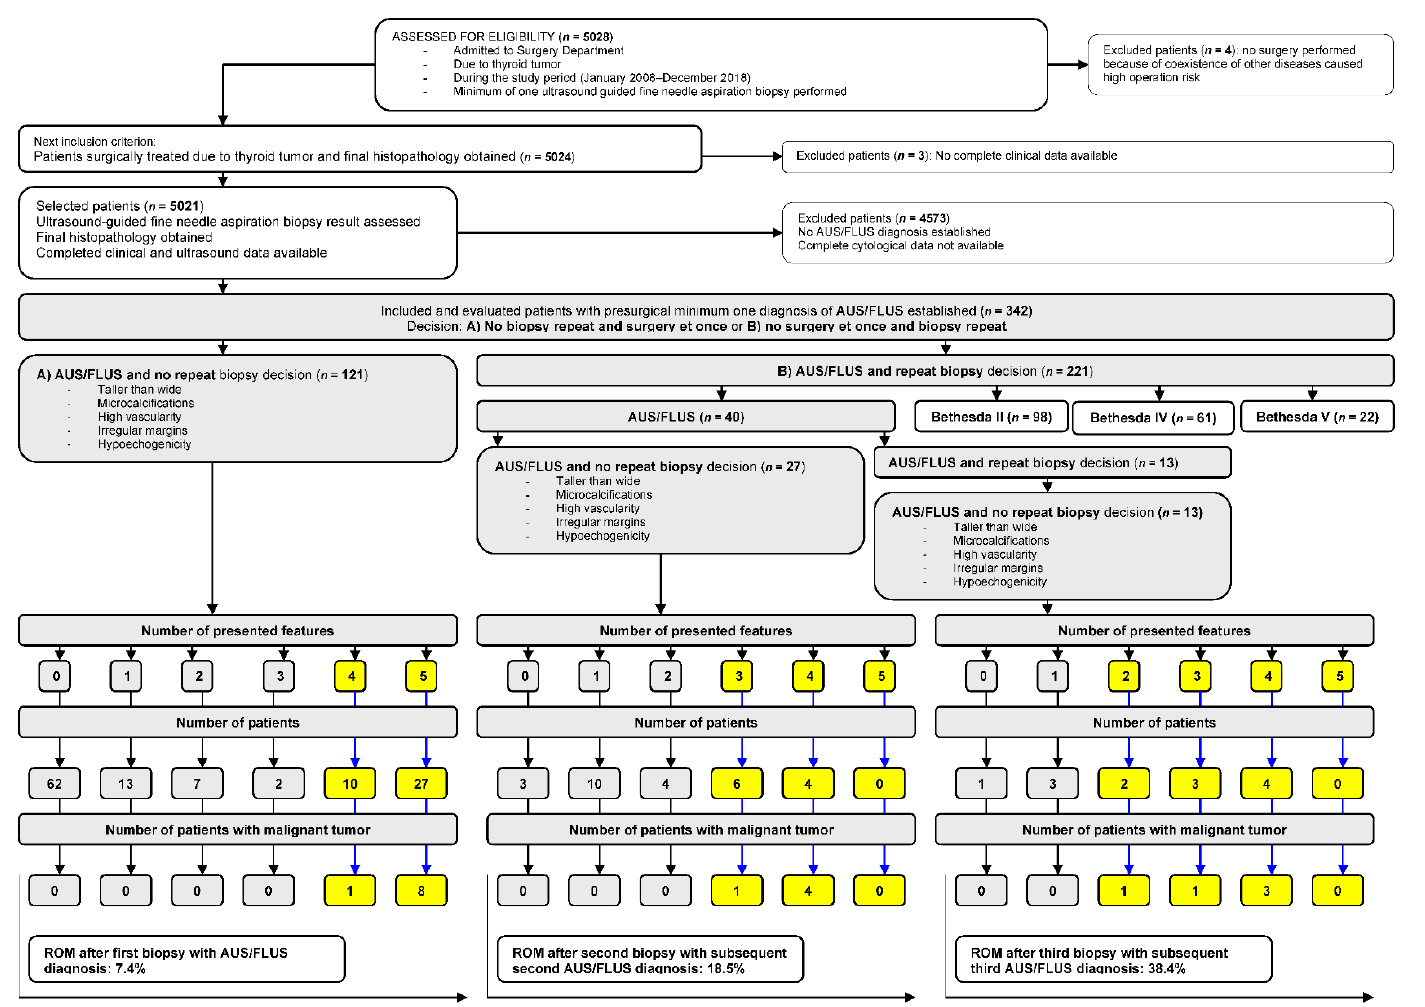
Figure 1. Selection of the study group from 5028 individuals referred for surgery from 2008 to 2018. All participants underwent a minimum of one UG-FNAB with a minimum of one AUS/FLUS diagnosis. All evaluated patients underwent surgery, and histopathology results were obtained in all cases.